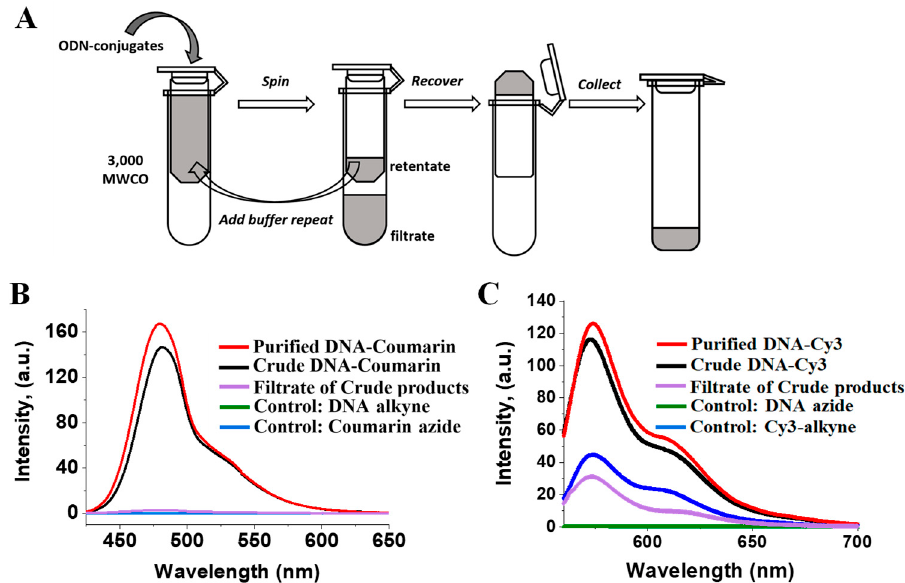
Figure 3. Illustration of membrane filtration principle based on MWCO centrifugal device and fraction analysis. ( A ) Schematic diagram of the centrifugation steps to evacuate unconjugated reactants and buffer exchange of the post-reaction mixture. Fluorescence assays of the collected fraction of the DNA-coumarin ( B ) and DNA-Cy3 ( C ) coupling reactions.